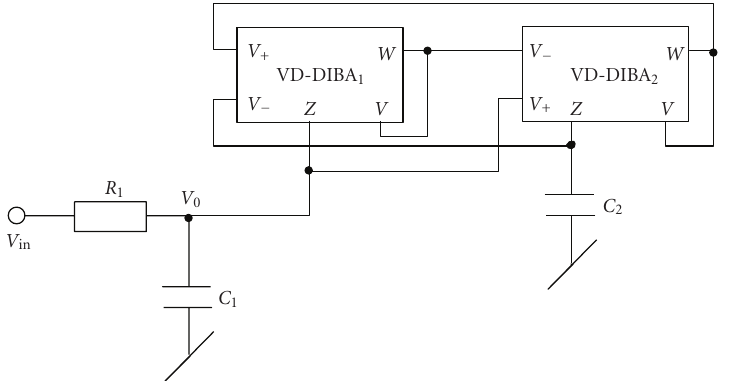
Figure 6: BPF realized by the new grounded simulated inductor.